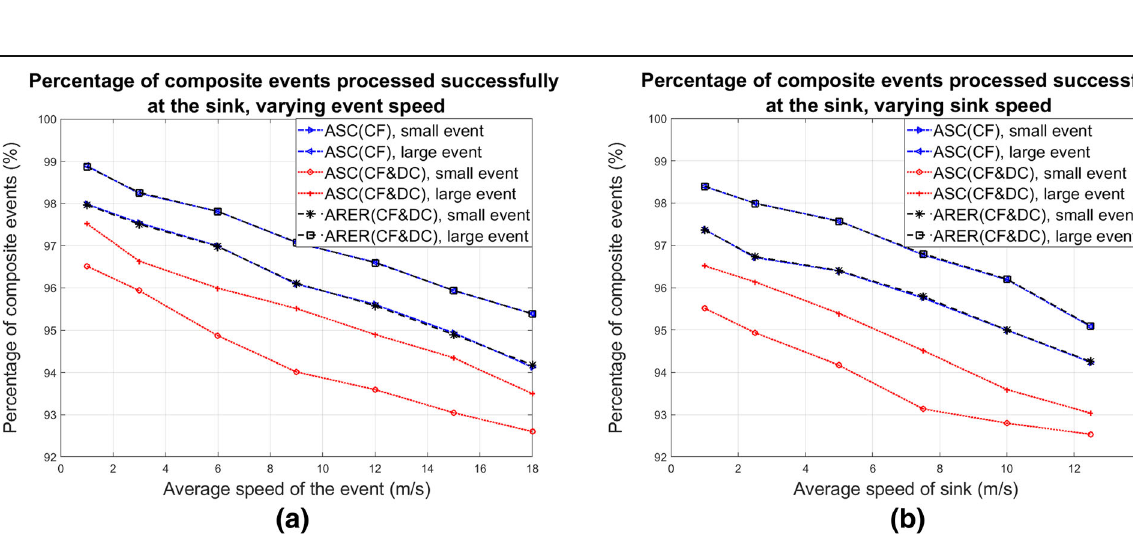
Fig. 8 Percentage of composite events successfully processed at the sink. a Different speeds of the event. b Different speeds of the